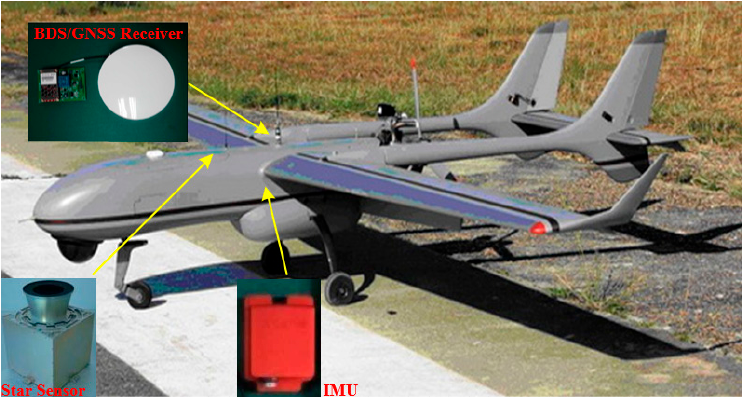
Table 4. Main parameters of Hemisphere P307 BDS/GNSS receiver.